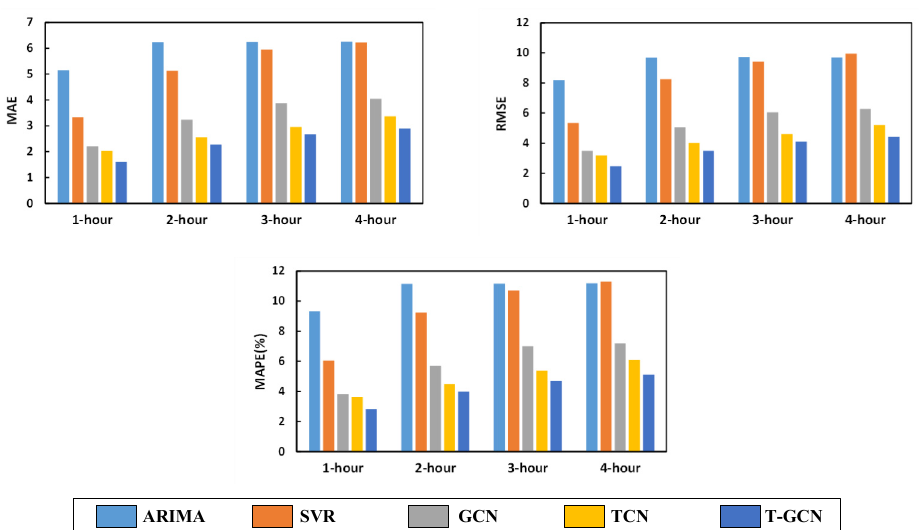
Figure 9. Performance comparison of different models in terms of MAE, RMSE, MAPE.